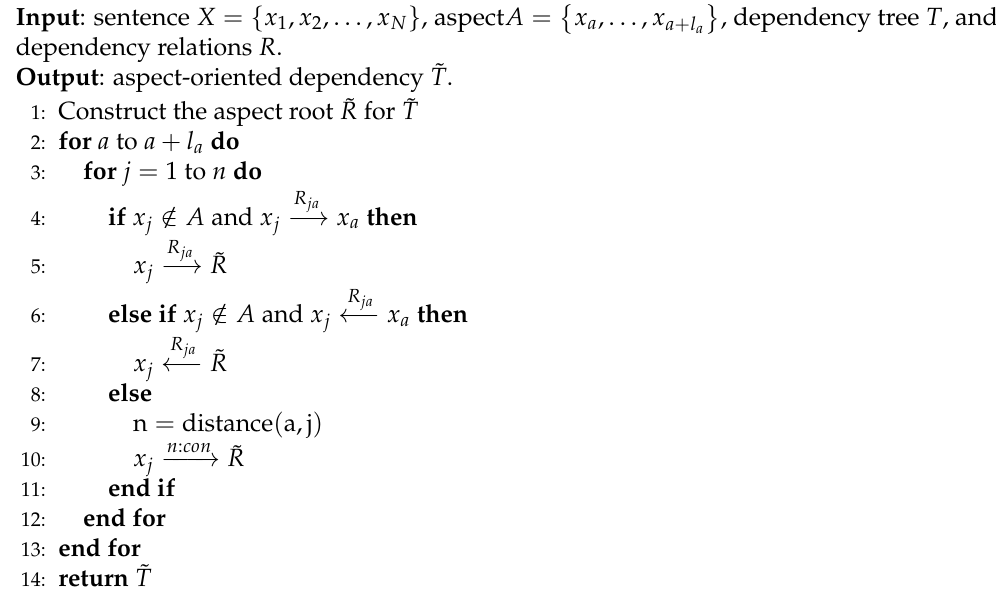
Algorithm 1 Aspect-Oriented Dependency